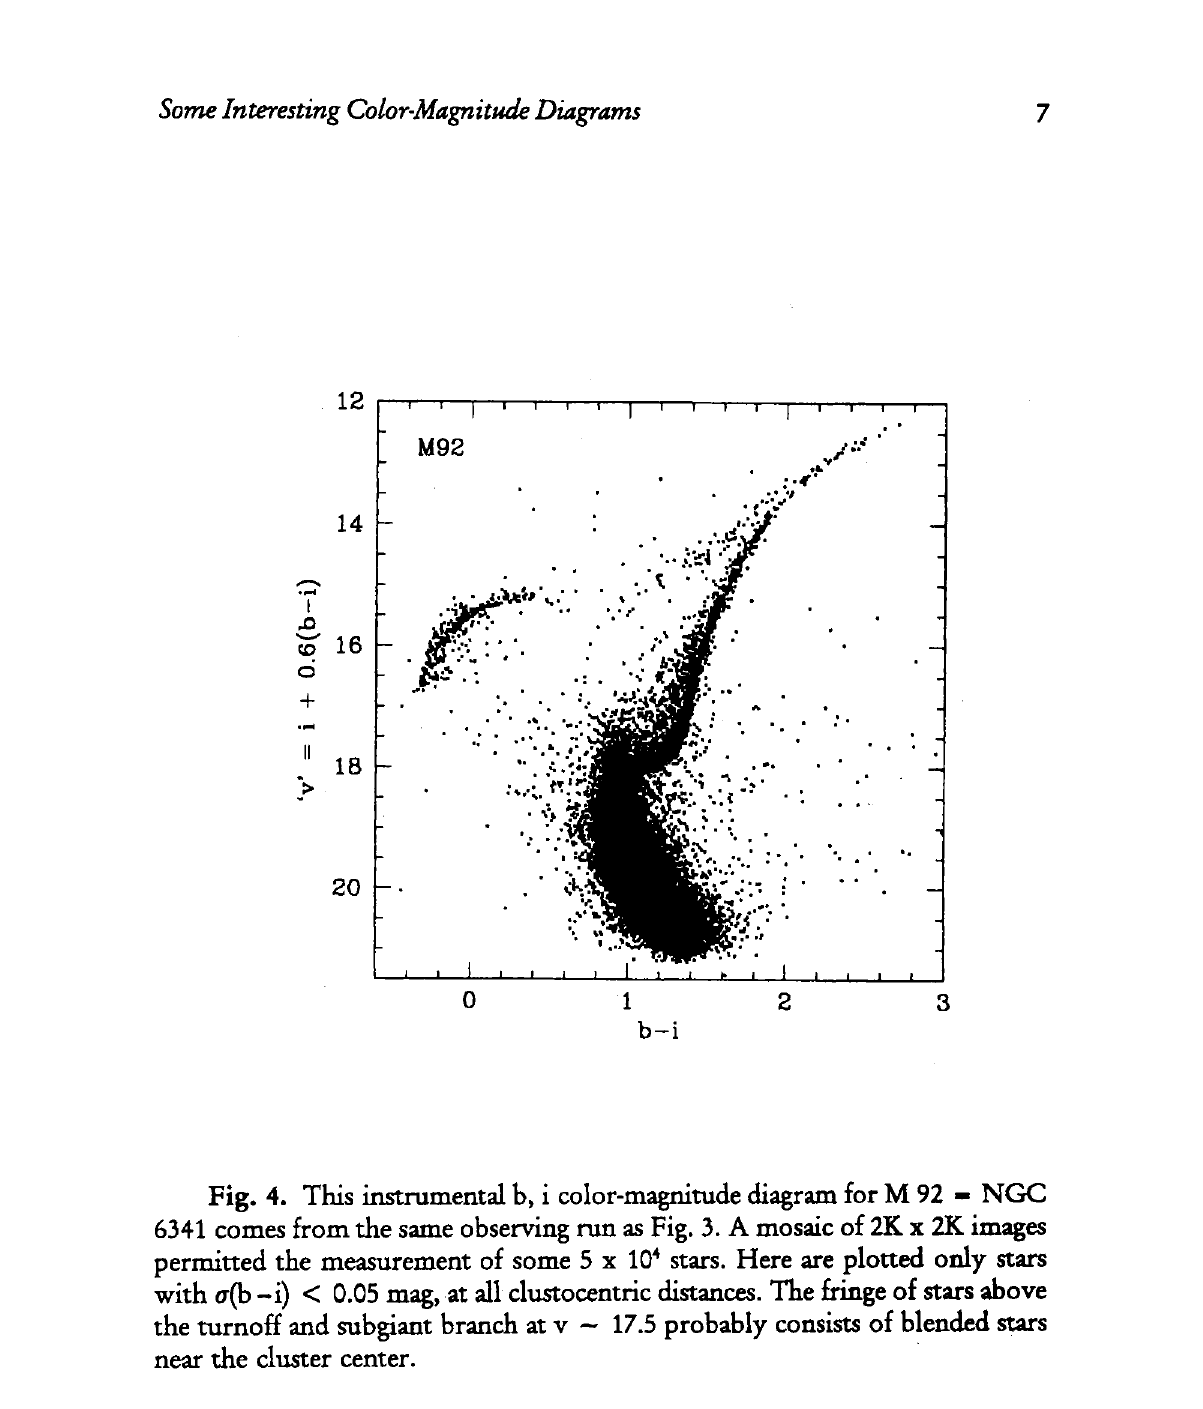
Fig. 4. This instrumental b, i color-magnitude diagram for Μ 92 - NGC 6341 comes from the same observing run as Fig. 3. A mosaic of 2K χ 2K images permitted the measurement of some 5 χ 10 4 stars. Here are plotted only stars with a(b -i) < 0.05 mag, at all clustocentric distances. The fringe of stars above the turnoff and subgiant branch at ν — 17.5 probably consists of blended stars near the cluster